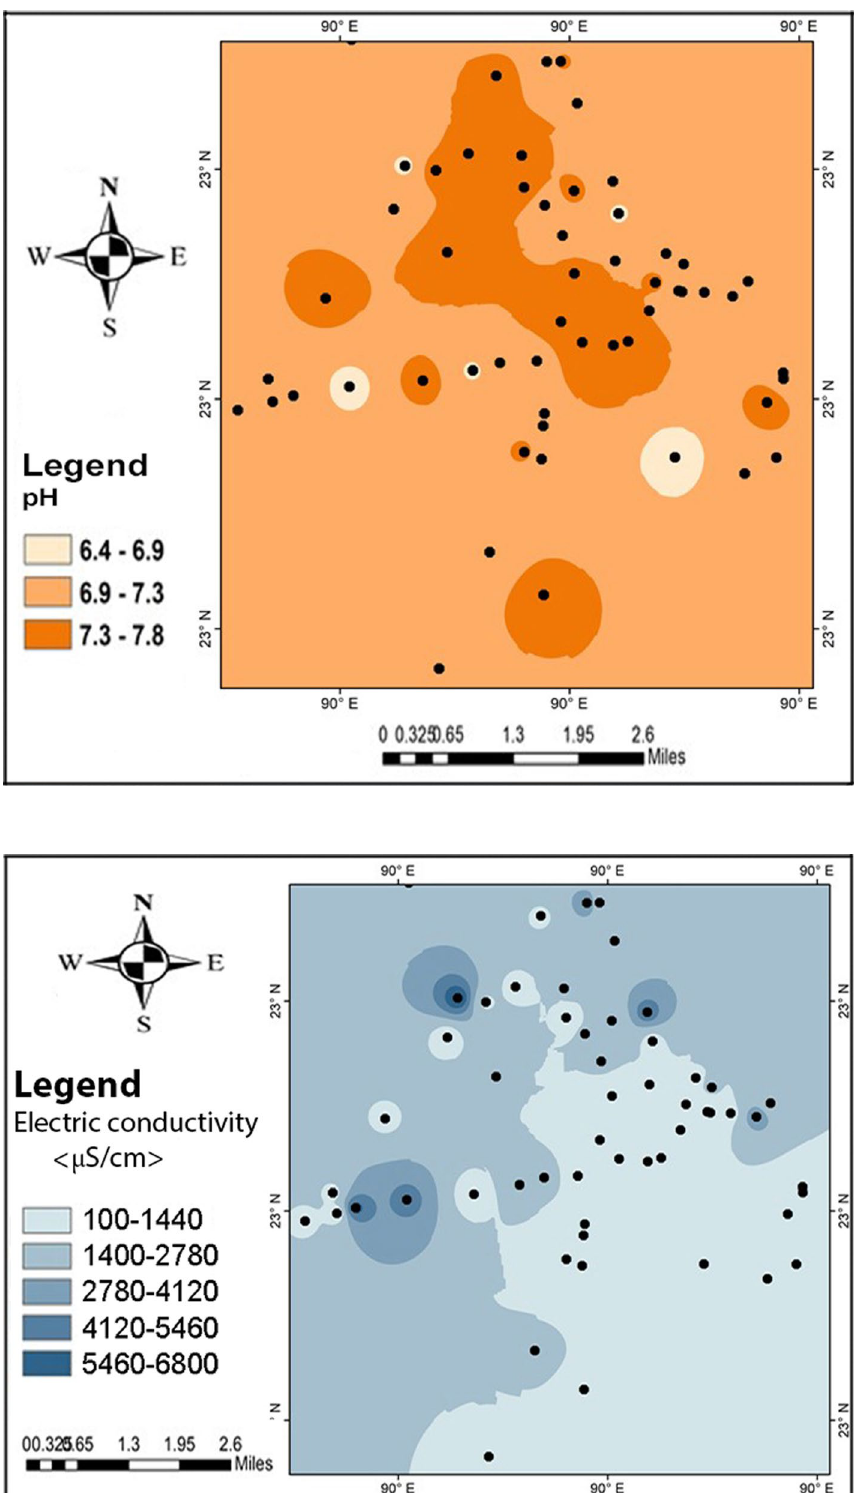
Fig. 3 Spatial distribution of pH in selected tube wells water